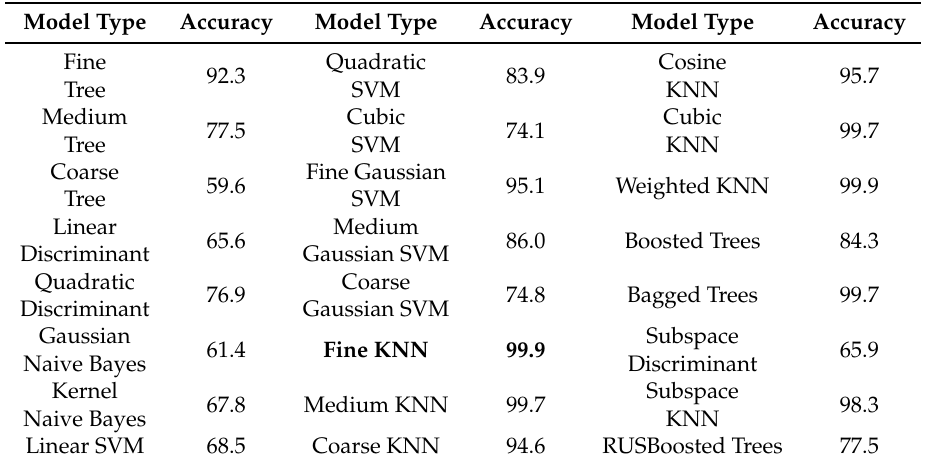
Table A2. Gesture classification training results. The model with the shortest training time and smaller misclassification cost were chosen among the models with the highest accuracy (%).